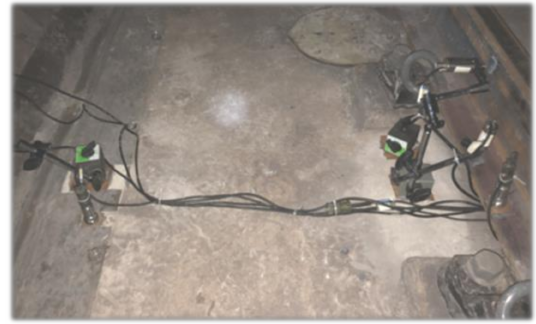
Figure 8. Site of displacement and acceleration measuring